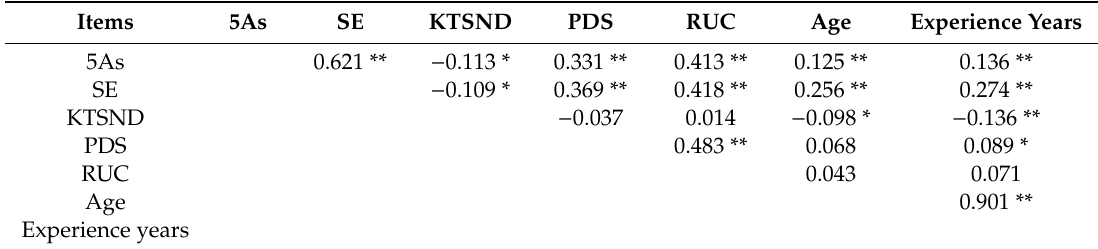
Table 3. Pearson correlation coe ffi cients matrix of study variables ( n = 521).